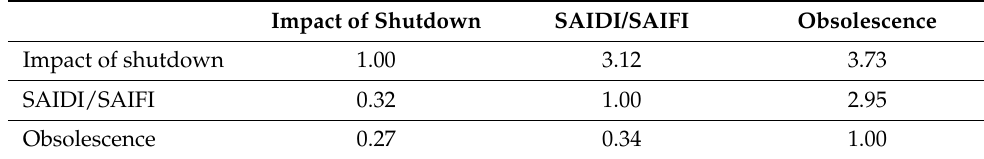
Table 4. Judgment matrix of criticality criteria.